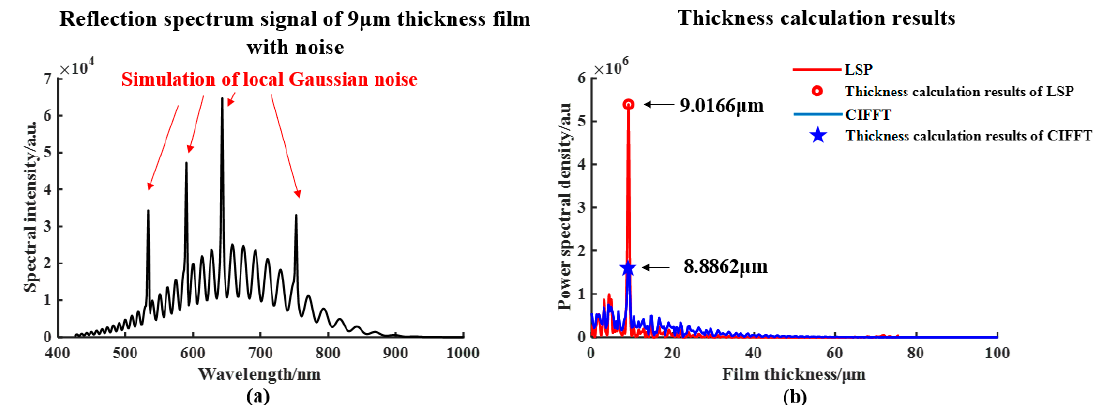
Figure 8. The influence of local Gaussian noise on the calculated thickness deviation. ( a ) Reflection spectrum signal including local Gaussian noise of 9 μ m thickness film. ( b ) Power spectral density and power spectrum calculated using Lomb–Scargle periodogram (LSP) and cubic spline interpolation combined fast Fourier transform (CIFFT) respectively membrane thickness.